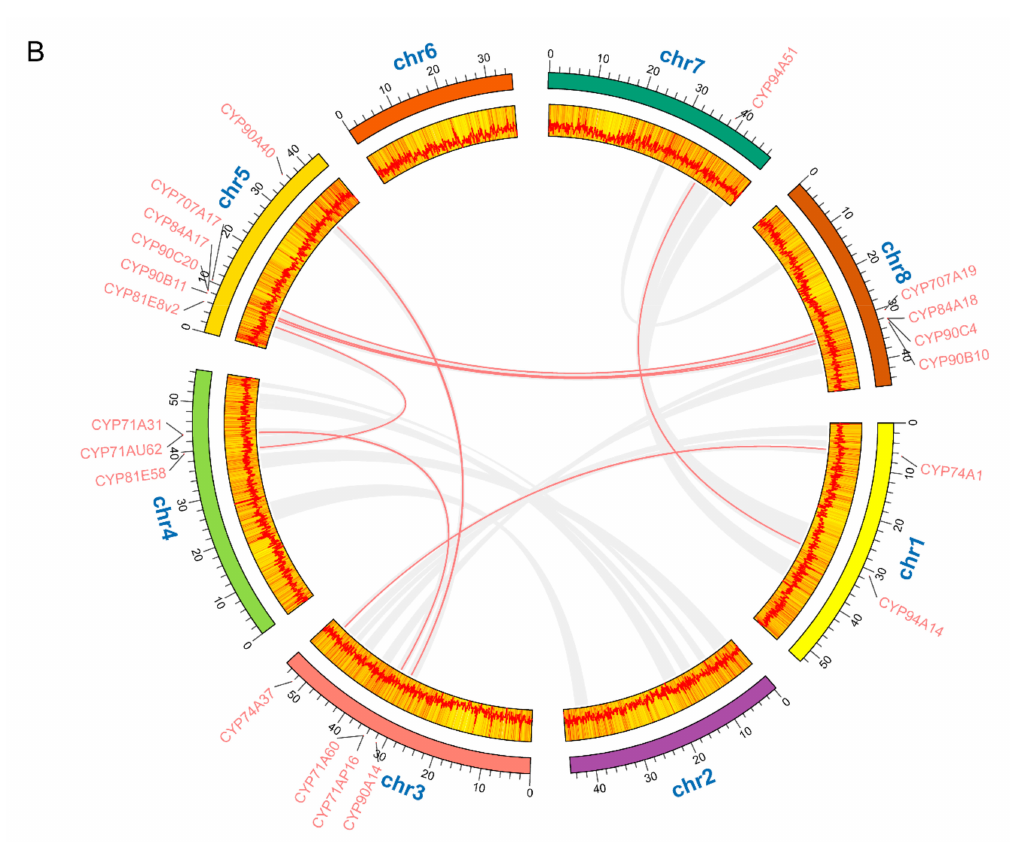
Figure 2. Chromosomal localization and gene duplication analysis of MtP450 genes. ( A ) All 346 MtP450s are shown on the chromosomes and indicated by their names. Chromosome numbers are indicated on the left side of each bar. Tandem duplicated genes are joined with blue arc lines. ( B ) The gray lines in the background indicate the collinear blocks within M. truncatula , while the red lines highlight the segmental duplication of MtP450 gene pairs. The yellow background on the chromosomes represents the gene density at each chromosomal position, and the vertical red line inside represents relatively higher gene density. The horizontal red line also represents gene density at each chromosomal position, with peak values representing relatively higher gene density and valley values representing relatively lower gene density.